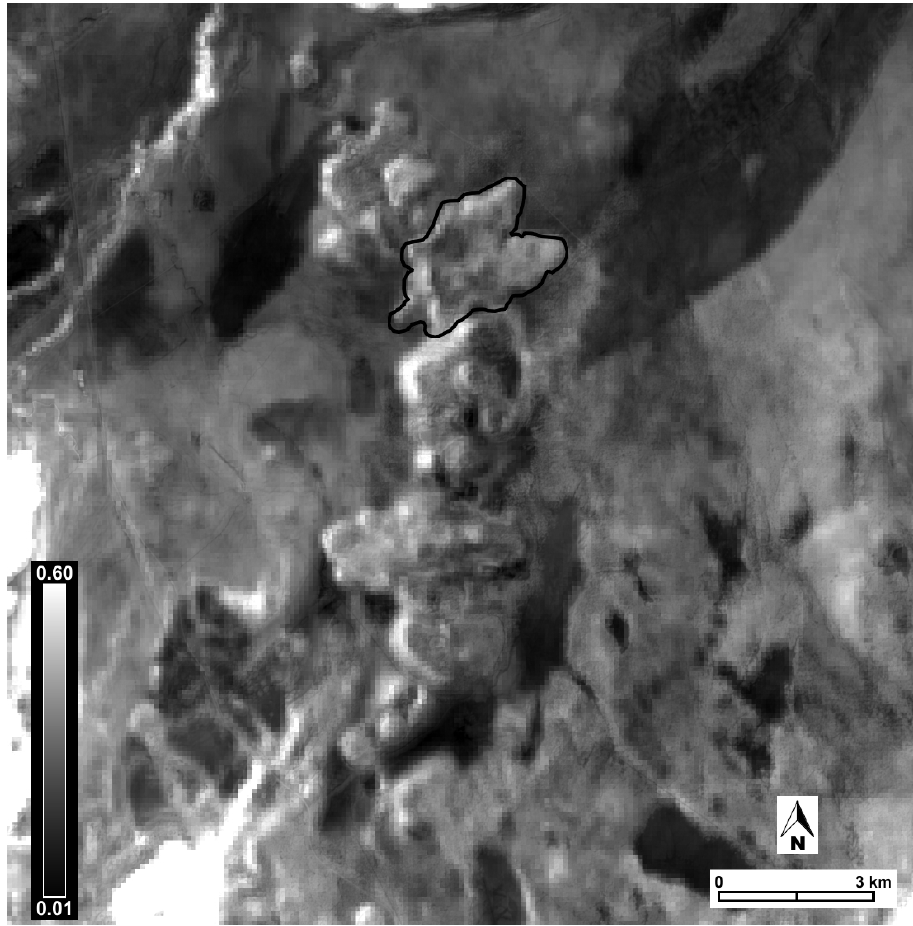
Figure 5. Apparent thermal inertia image derived for this study from the data shown in Figure 4. June Lake ( lower left ) and northwest-facing steep slopes have very high ATI values, whereas large, non-vegetated pumice deposits and old fire scars ( upper right ) (exposing the underlying pumice) have the lowest ATI values. Note that North Coulee has a range of ATI values 942 consistent with the preliminary work of Ramsey and Crown (2010) (see Figure 3).